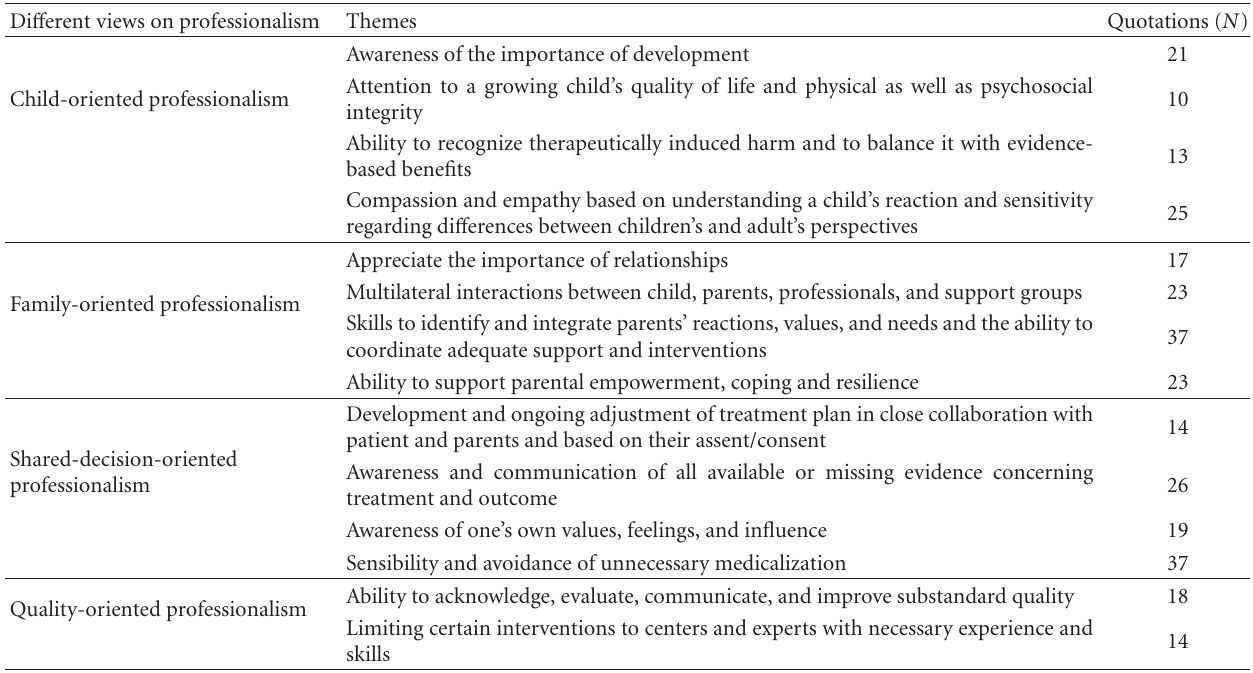
Table 2: Summary of resulting categories concerning professionalism on